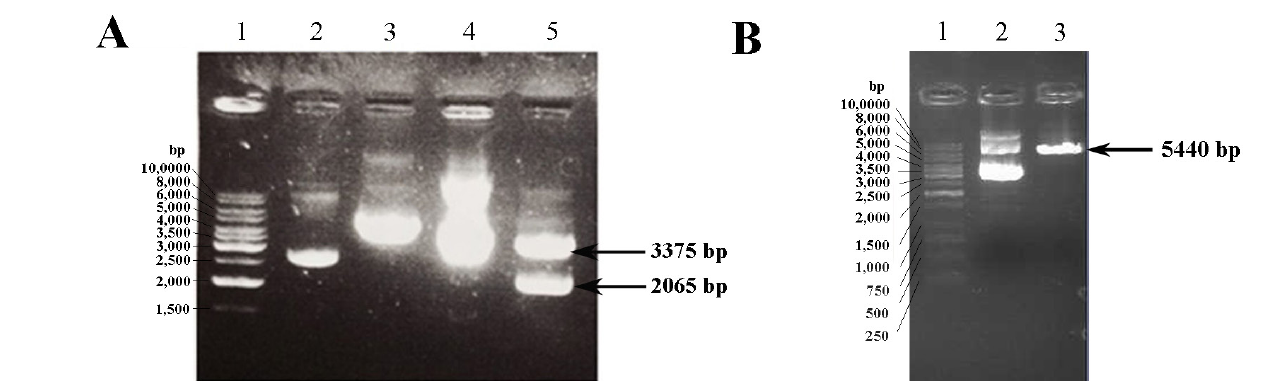
FIGURE 1 - (A) Gel-electrophoresis analysis of the mt-PA- pTracer-SV40 Plasmid by Sma I restriction enzyme digestion on 1% agarose gel. Lane 1, DNA Ladder 1 Kb; Lane 2, pTracer-SV40 Plasmid without the mt-PA gene; Lane 3, pTracer-SV40 Plasmid without the mt-PA gene digested by Sma I restriction enzyme; Lane 4, pTracer-SV40 Plasmid with the mt-PA gene; Lane 5, pTracer-SV40 Plasmid with the mt-PA gene digested by Sma I restriction enzyme. (B) Gel-electrophoresis analysis of the